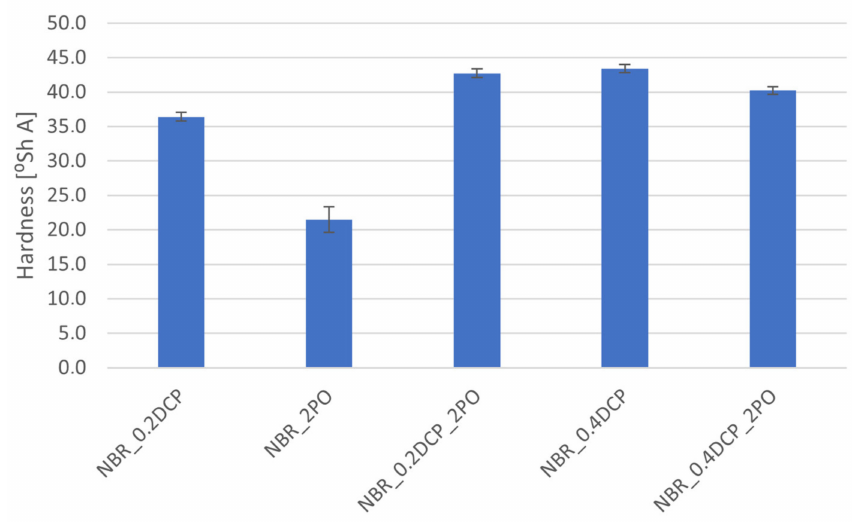
Figure 12. Influence of peroxide curing system modification on hardness of NBR samples.